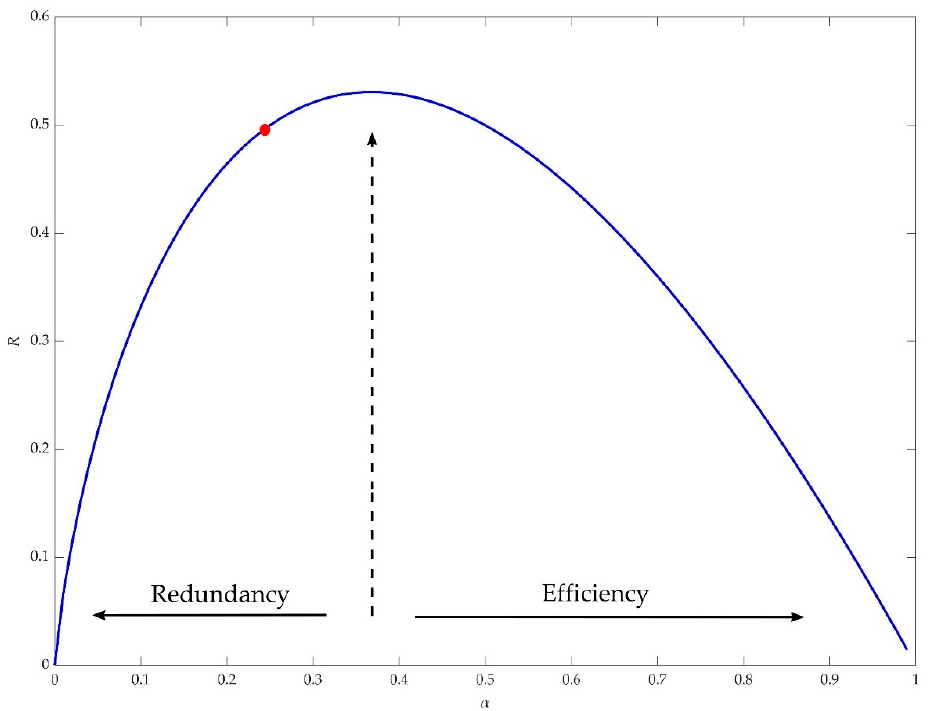
Figure 3. Relationship between the order degree and robustness ® in the virtual water system of Tibet.